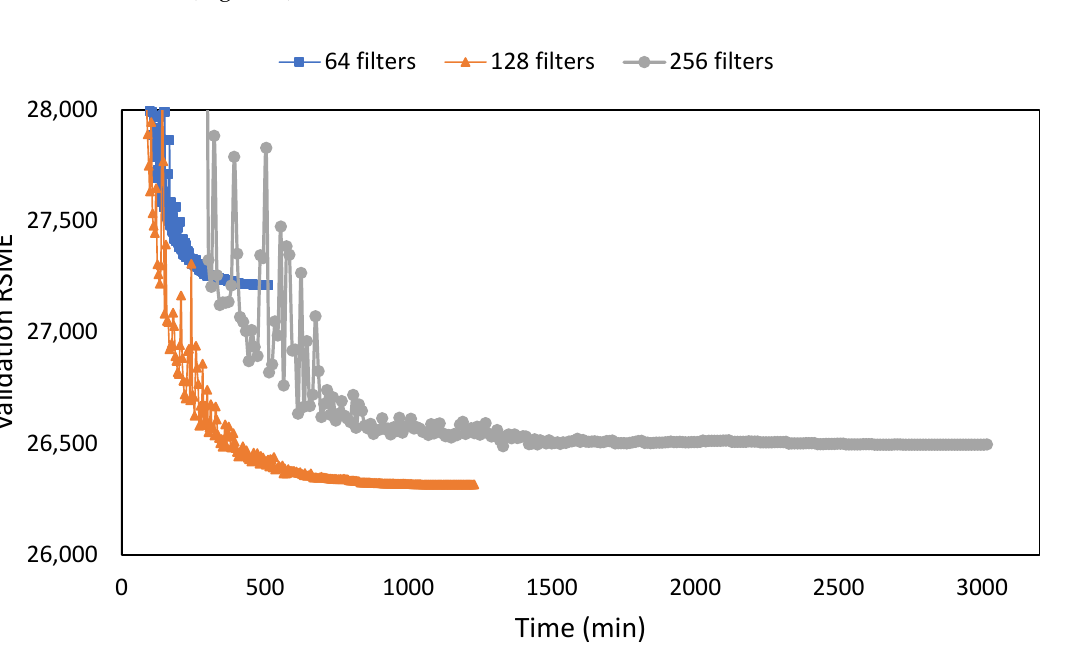
Figure 7. Training results between different filter numbers for 300 epochs with the X-axis representing training